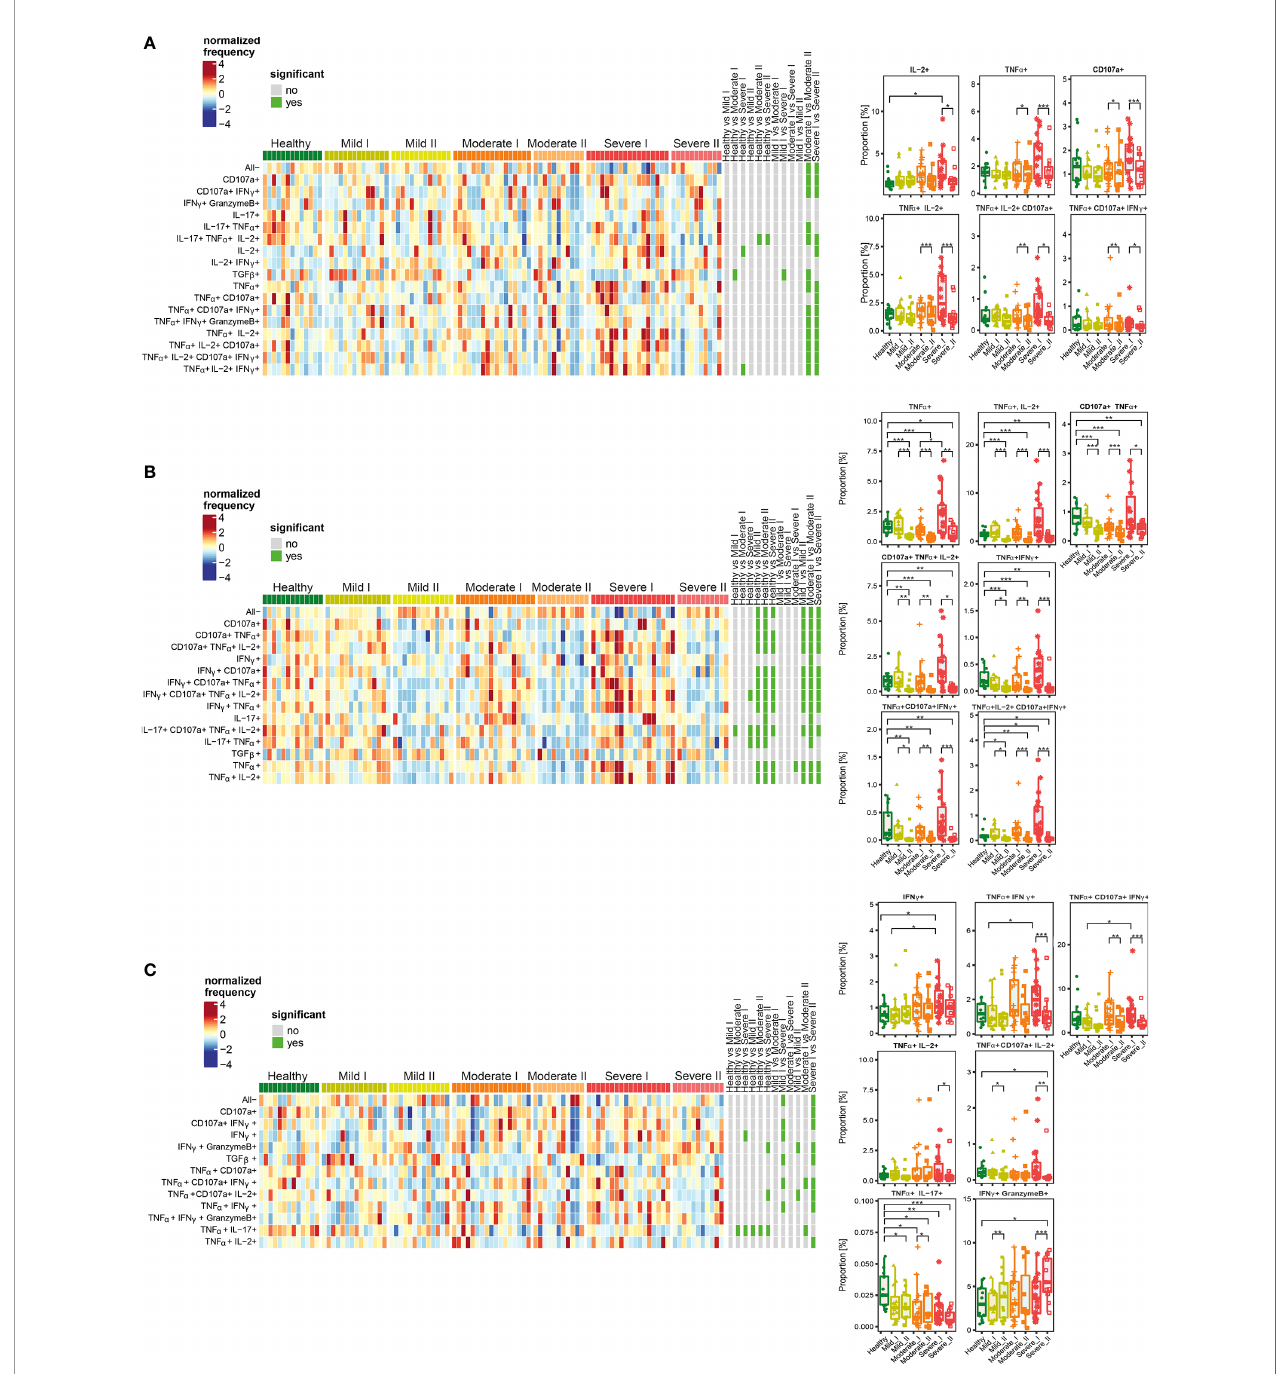
FIGURE 6 | Unsupervised analysis of cytokine production by CD4+ (A) , Treg (B) and CD8+ (C) cells from convalescent patients after mild, moderate and severe COVID-19 as well as healthy donors analyzed at time I and time II. Upper panels - Heatmaps showing cell clusters identi fi ed by FlowSOM with differential analysis of all severity groups of COVID-19 convalescent patients (mild, moderate, severe) as well as healthy controls at the time points I and II. The heat represents arcsine- square-root transformed cell frequencies that were subsequently normalized per cluster (rows) to mean of zero and standard deviation of one. The color of the heat varies from dark blue indicating relative under-representation to red indicating relative over-representation. Bars at the right indicate signi fi cant differentially abundant clusters (green). The population without any activity (negative for all markers) has been marked as “ All- ” . Lower panels – differential proportion of selected clusters presented as % of analyzed cells. *p ≤ 0,05; **p ≤ 0,01; ***p ≤